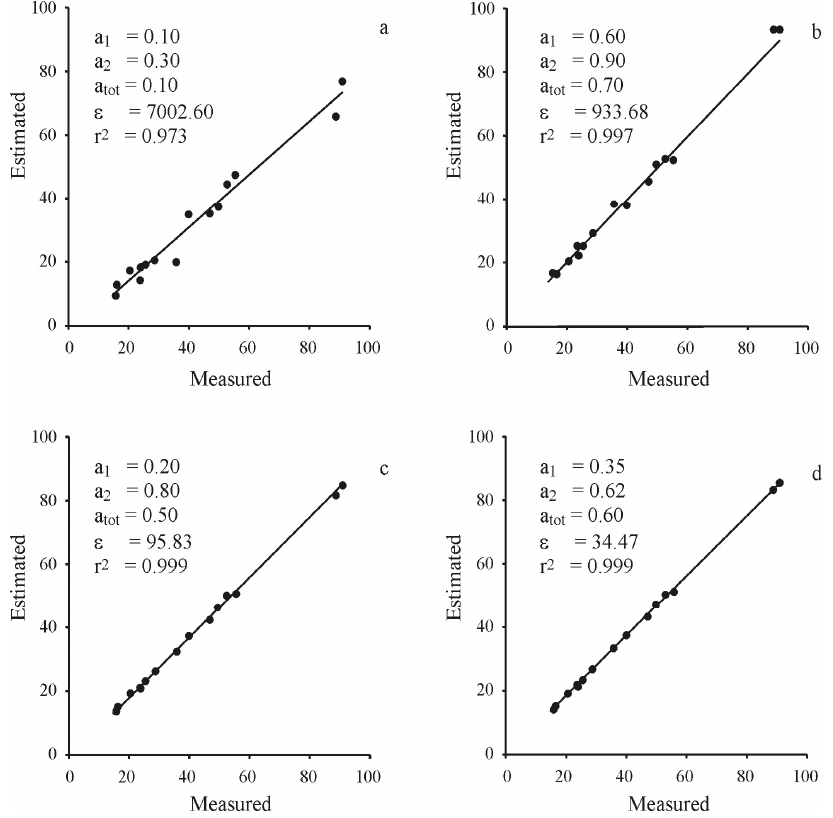
Figure 8. Examples for the result of the trial-and-error method at different (a 1 , a 2 , a tot ) values ( a-c ). ( d ) The best solution found.